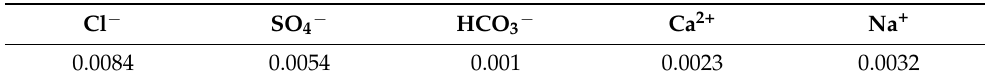
Table 2. Composition of the experimental soil (wt.%).